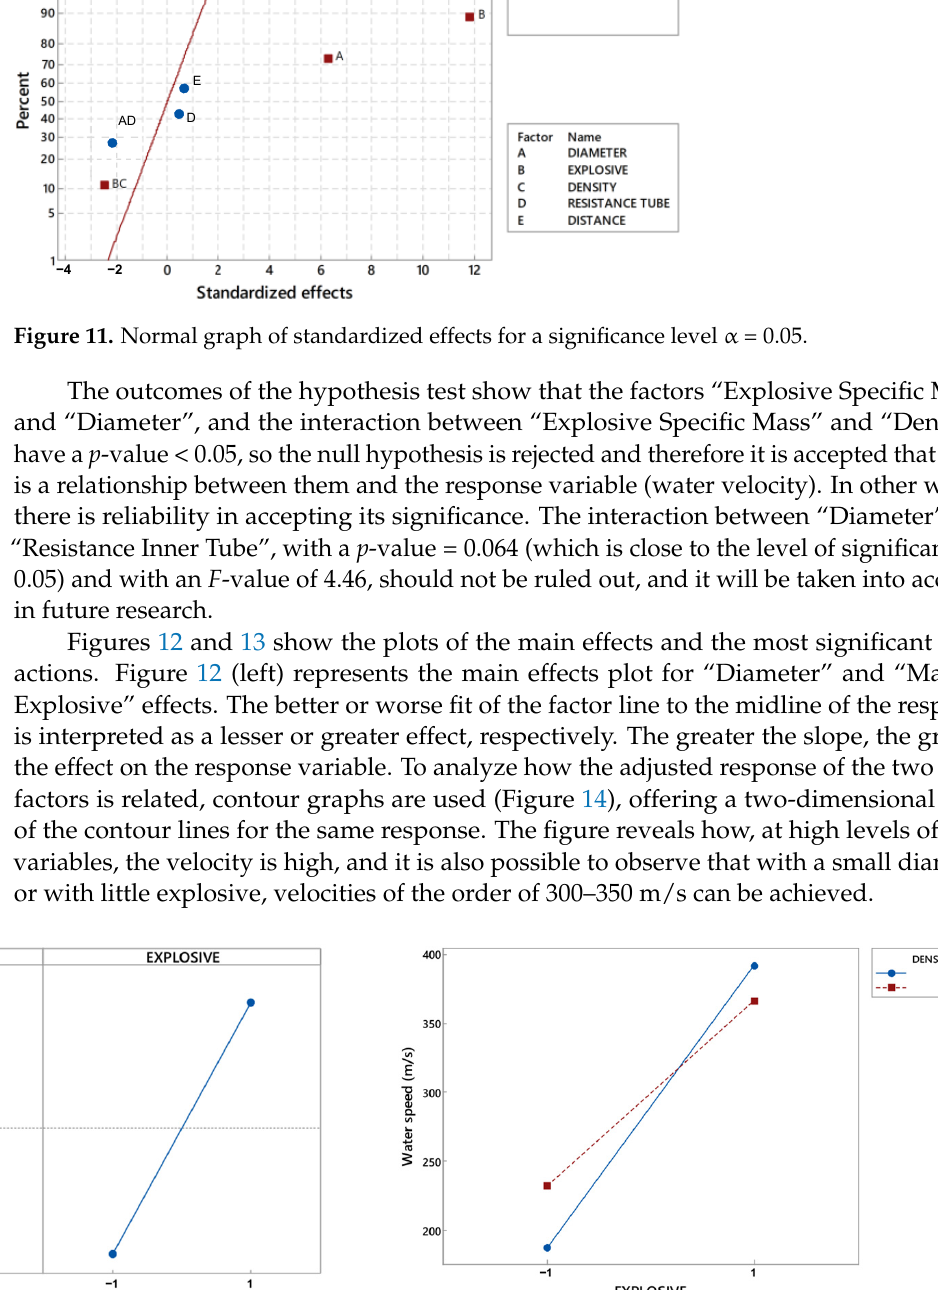
Figure 10. Pareto diagram of absolute values of the standardized effects.